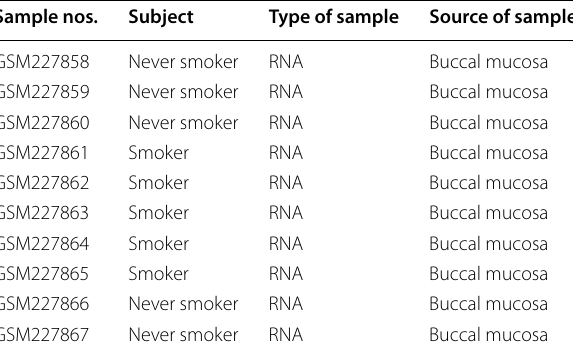
Table 1 Gene expression data samples included in the current analysis Sample